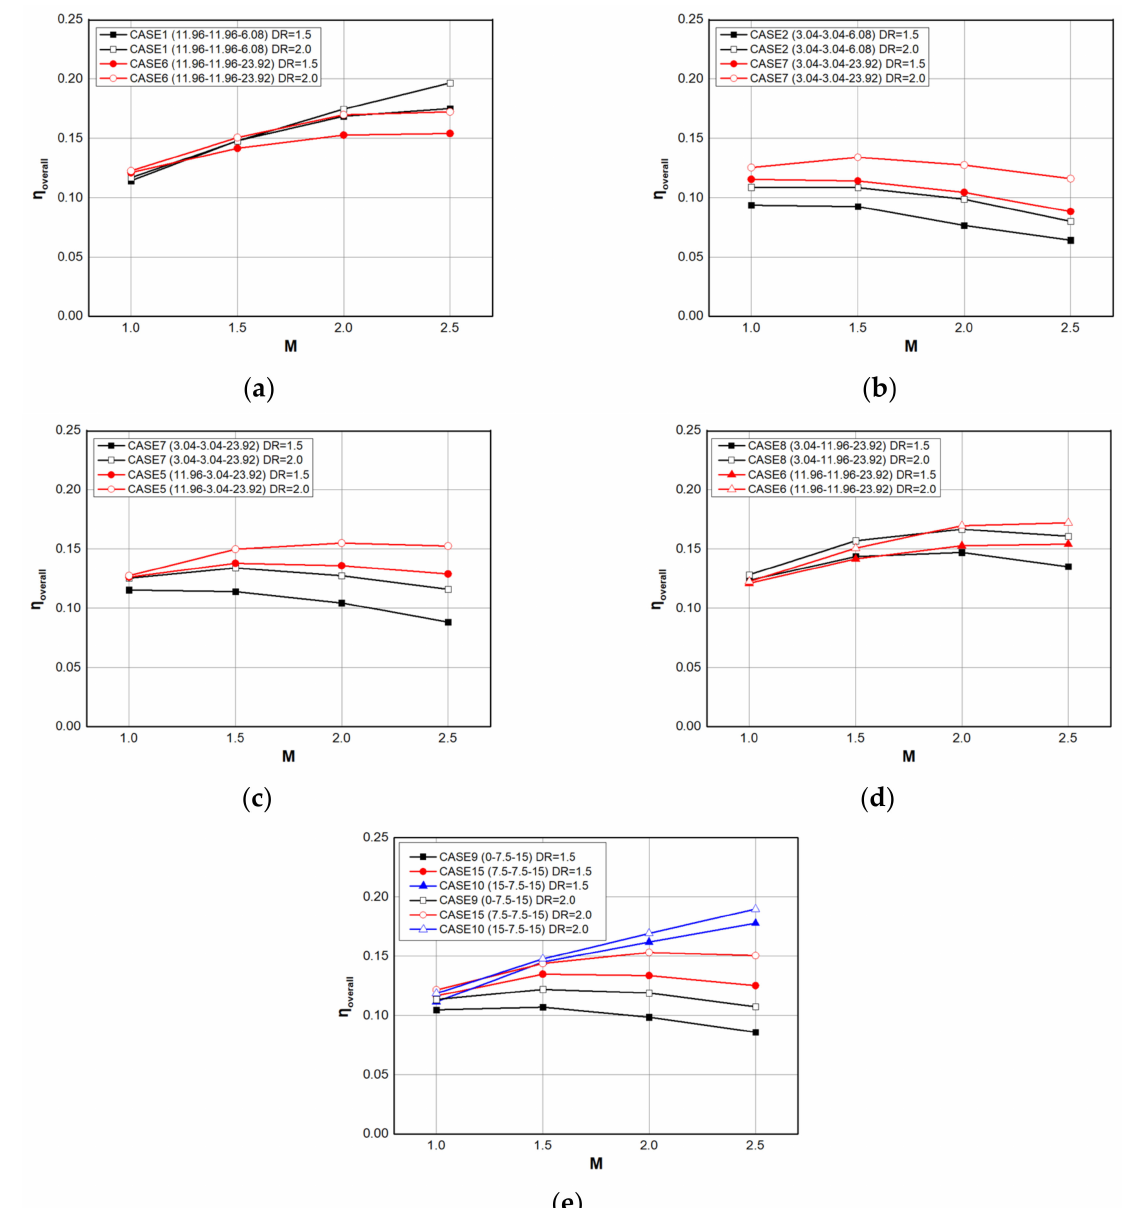
Figure 7. Overall averaged FCE for the effect of windward lateral expansion angle: ( a ) γ ww -11.96-6.08 cases; ( b ) γ ww -3.04-6.08 cases; ( c ) γ ww -3.04-23.92 cases; ( d ) γ ww -11.96-23.92 cases; ( e ) γ ww -7.5-15